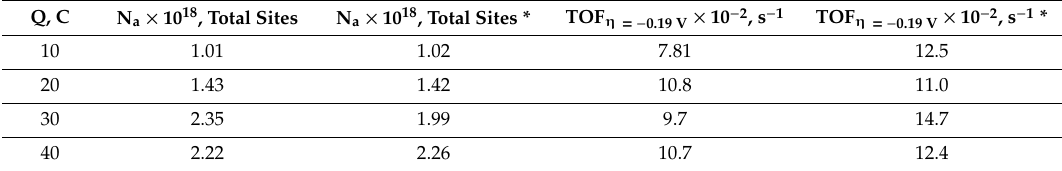
Table 3. Calculated numbers of active sites and turnover frequencies (at − 0.2 V) for the electrodeposited MoS 2 films from electrolytes containing MoS 42 − and MoS 42 − + NaH 2 PO 2 (denoted with *).